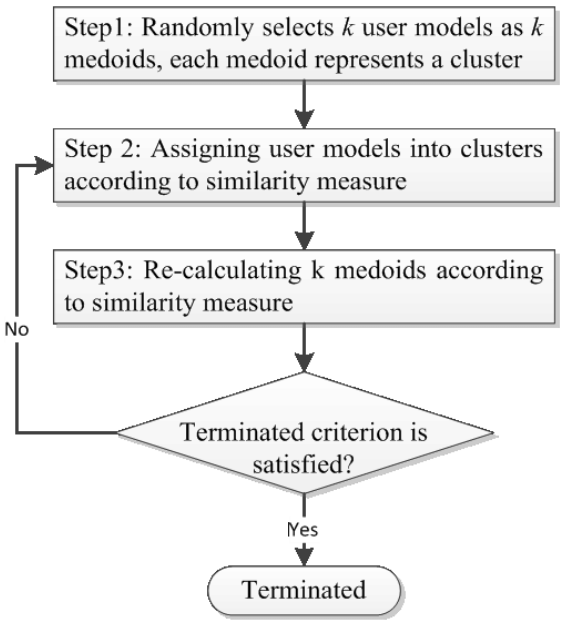
Figure 4. Raw data clustering of the k-medoids algorithm.